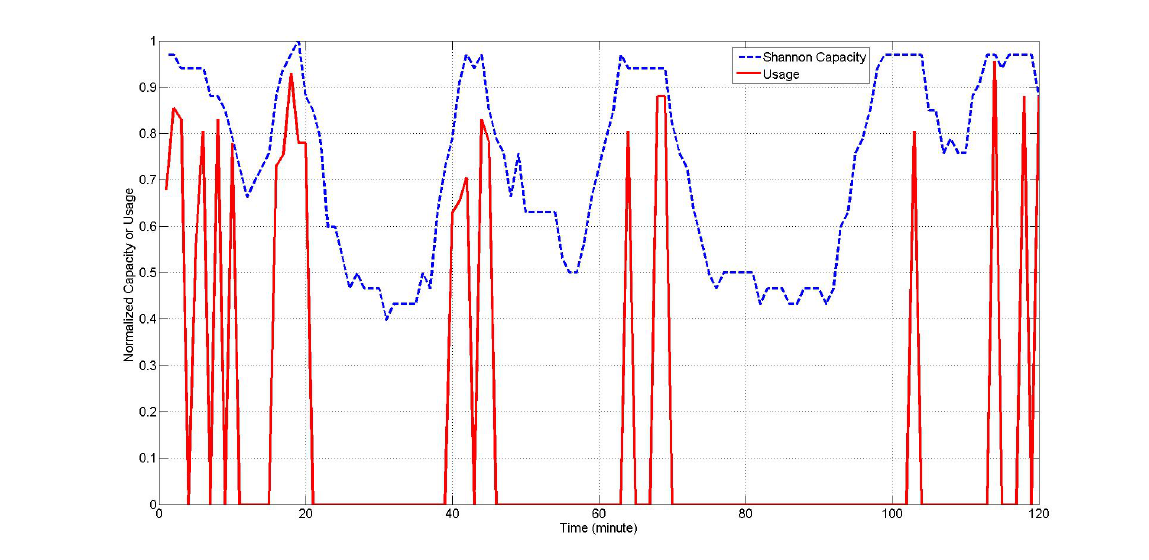
Figure 5. Comparison between normalized channel usage with the dropping of data packets in the event of collision and the calculated point-to-point communication Shannon capacity of a wireless channel with respect to time.